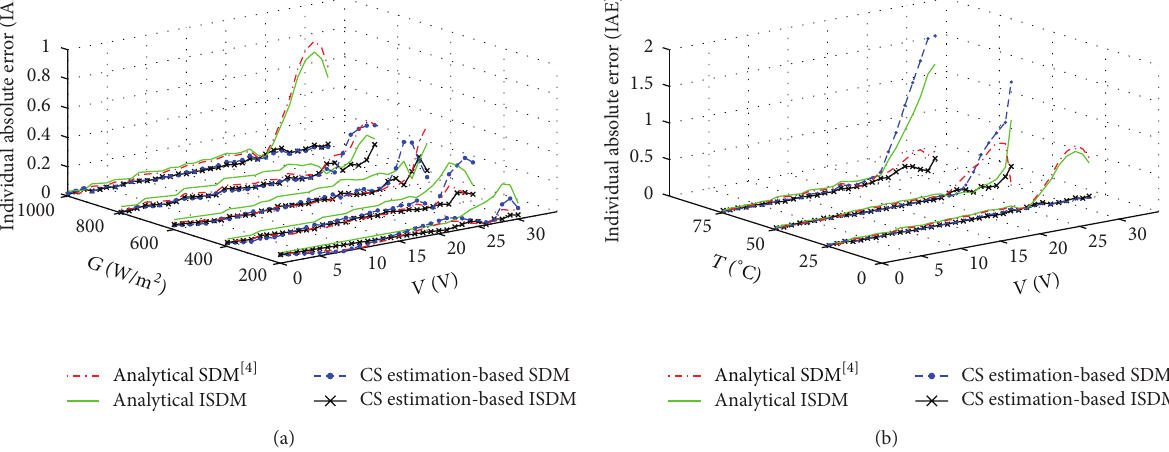
Figure 4: A comparison of the individual absolute errors among different PV modeling methods: (a) under different irradiance levels; (b) under different temperature